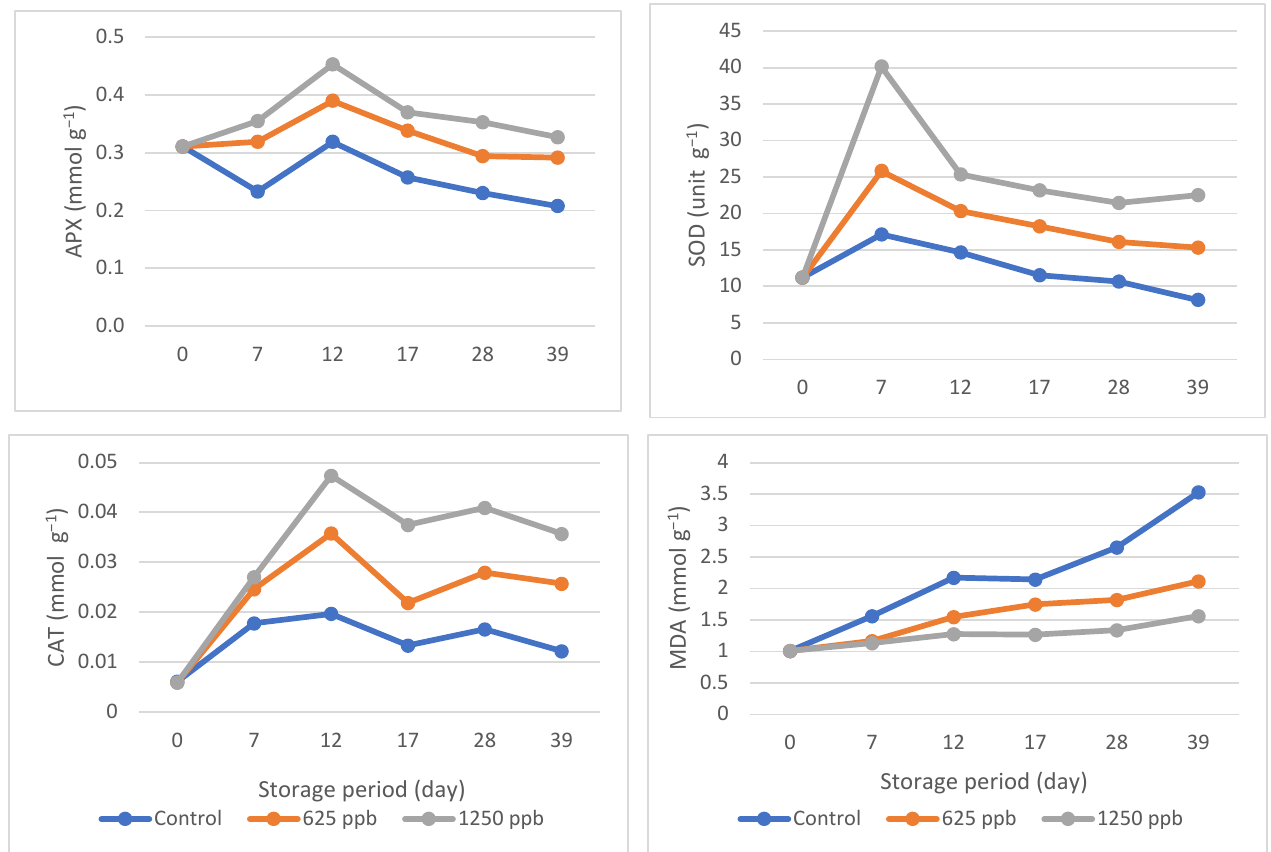
Figure 1. The APX, SOD, CAT, and MDA during storage of ‘Seyit F1’ cocktail tomato ( Solanum lycopersicum L.).